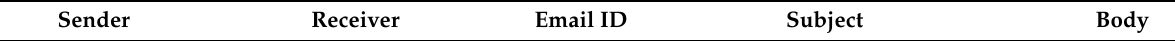
Table 1. Emails Sample.